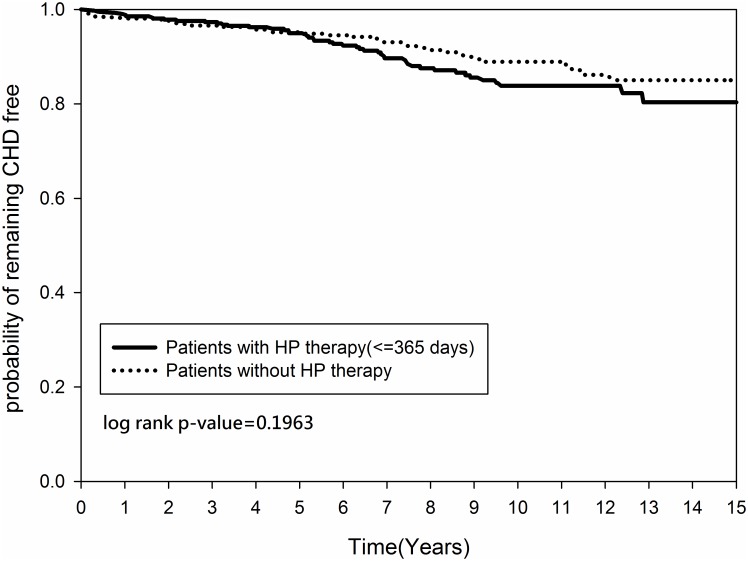
Kaplan-Meier curve for coronary heart disease rate by age between patients (age ≥ 65 years old) with and without Helicobacter pylori therapy.